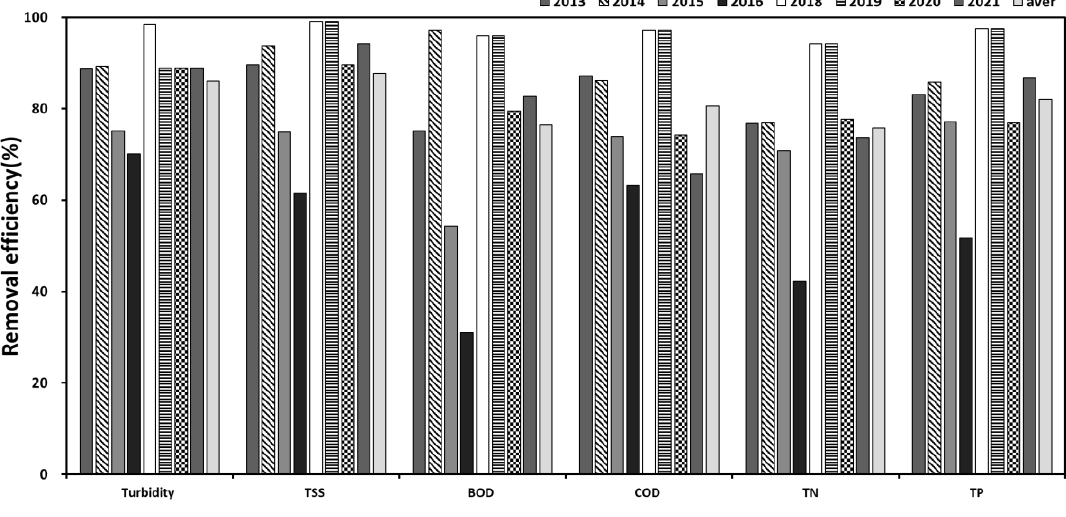
Figure 6. Average annual pollutant removal efficiency.